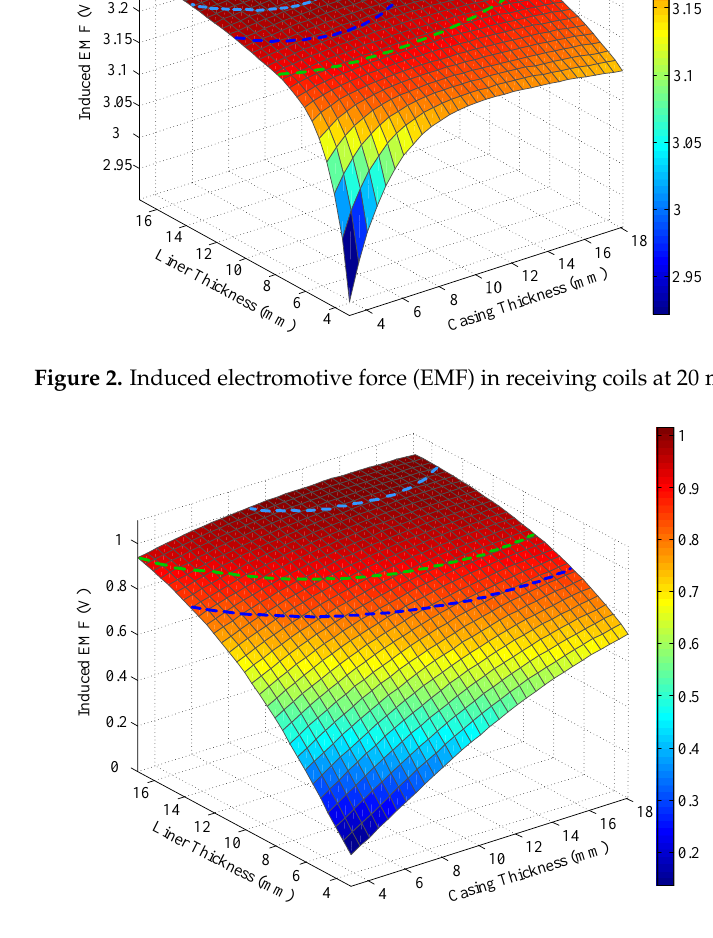
Figure 3. Induced EMF in receiving coils at 50 ms.